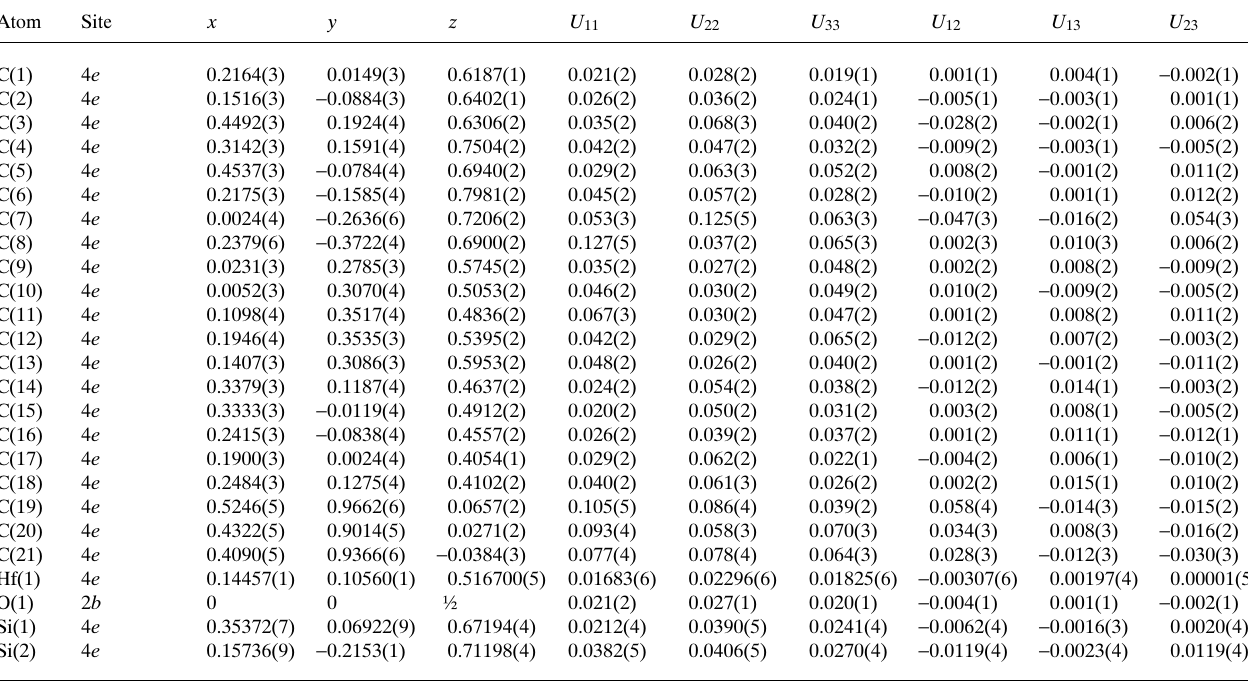
Table 3. Atomic coordinates and displacement parameters (in Å 2 )